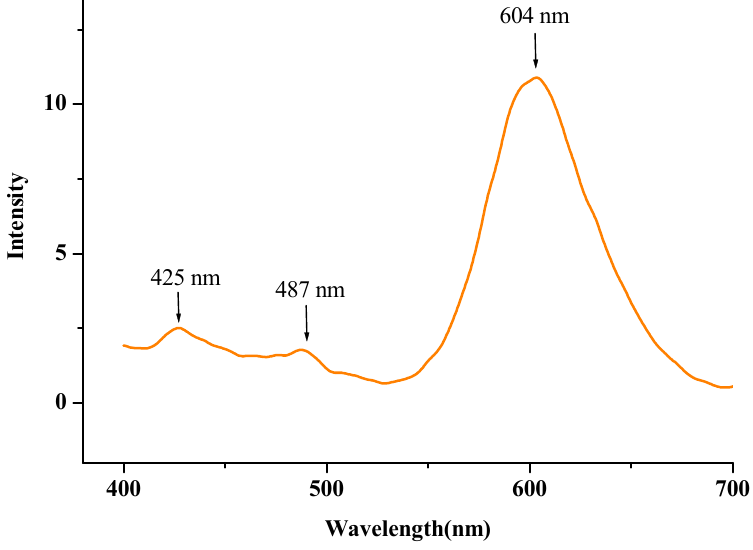
Figure 5. Solid-state fluorescence spectra of the title